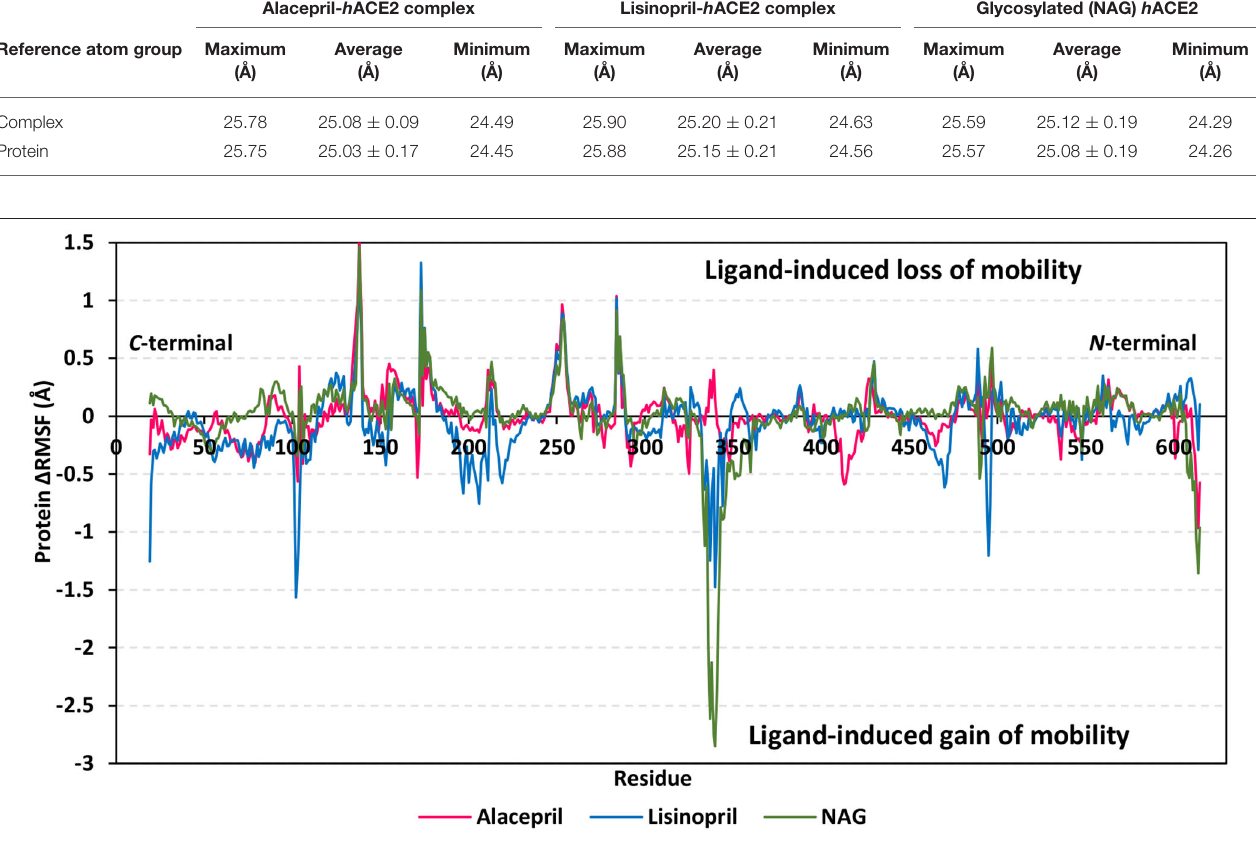
TABLE 2 | The Rg values for investigated ligand- h ACE2 complexes across the all-atom MD simulation. Alacepril- h ACE2 complex